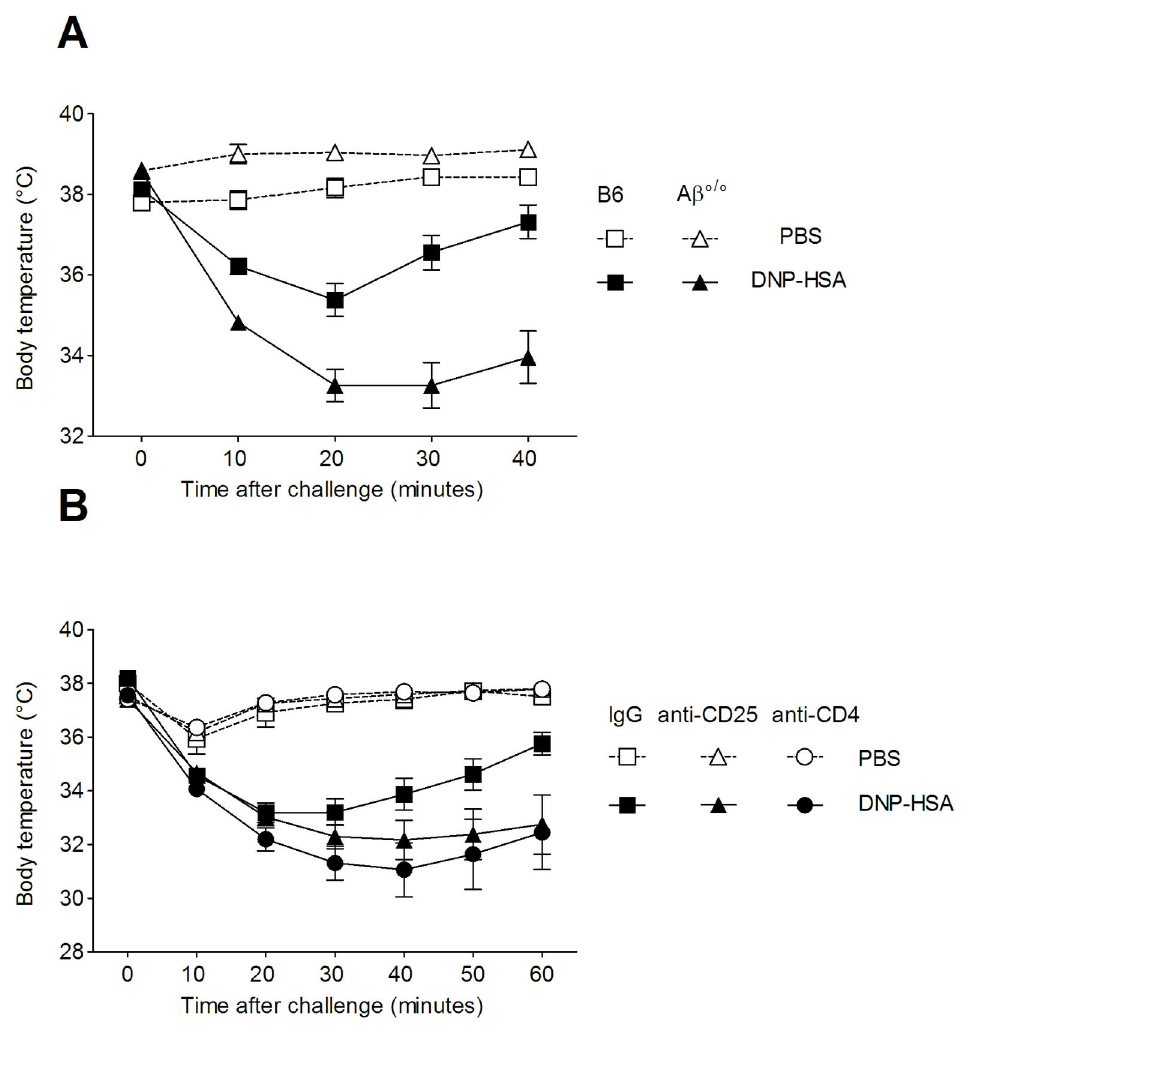
Figure 2. Analysis of anaphylaxis in settings of CD4 + CD25 + T cell deficiency. DNP-specific PSA was induced A) in MHC class II-deficient mice (Aβ °/° ) ( triangles ) and WT B6 ( squares ) mice and B) in B6 mice injected with either an anti-CD25 mAb ( triangles ), an anti-CD4 mAb ( circles ) or a control rat IgG mAb ( squares ). All mice were passively sensitized with anti-DNP IgE and challenge with DNP-HSA ( black symbols ) or PBS ( open symbols ). Data show mean (± SEM) values of body temperature at various times after challenge. Figure 2A shows 1 representative experiment out of 3 (n= 5-6 mice/group); p** = 0,0027 for DNP-challenged Aβ KO versus WT B6 (p** = 0,0074 and p = * 0,0286, for the other two experiments). Figure 2B data are from 2 pooled experiments (n= 5 mice/group); p* = 0,017 for DNP-challenged WT B6 versus anti-CD4-mAb treated mice and p* = 0,05 for DNP-challenged WT versus anti-CD25 mAb-treated B6 mice.